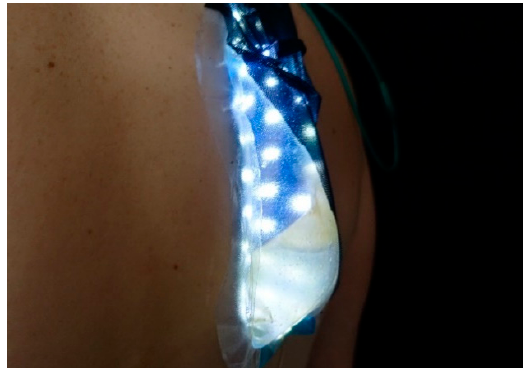
Figure 5. Mock-up 3: A soft light bubble extends the